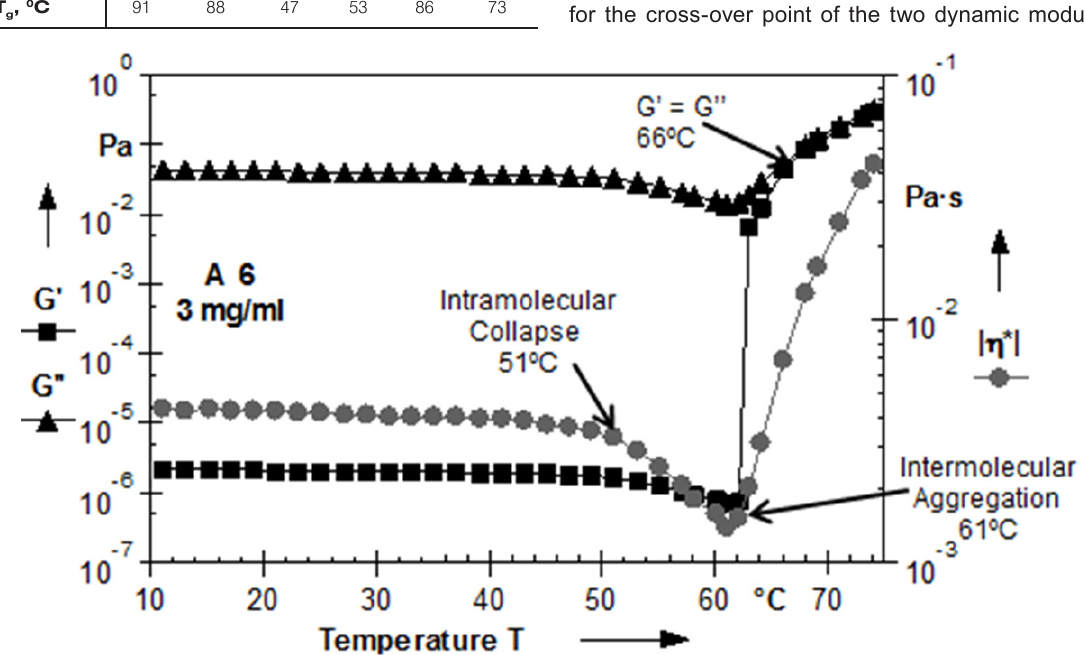
Figure 4. Temperature sweep for a 3 mg mL -1 solution of PSI-g-poly(DMA-co-MMA) (A6) and suggested mechanism of